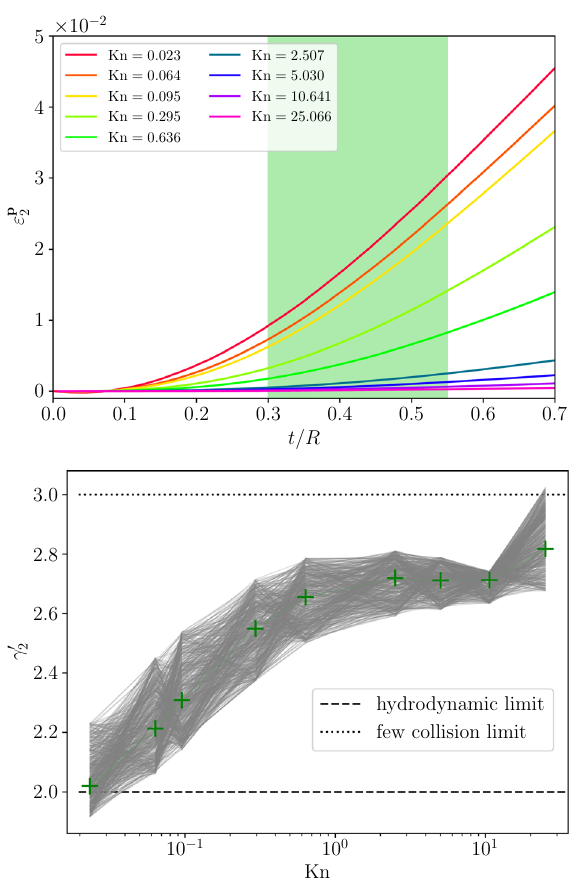
= v E for various 2 2 Fig. 13 Early time development of energy-weighted triangular flow v E for Kn ≈ 25 (top panel) and Kn ≈ 5 (bottom panel) from numerical 3 simulations with the 2 → 0 collision kernel (green) and analytical calculations at O (σ)